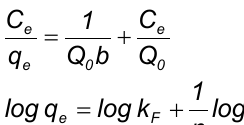
C.I. Acid Orange 7